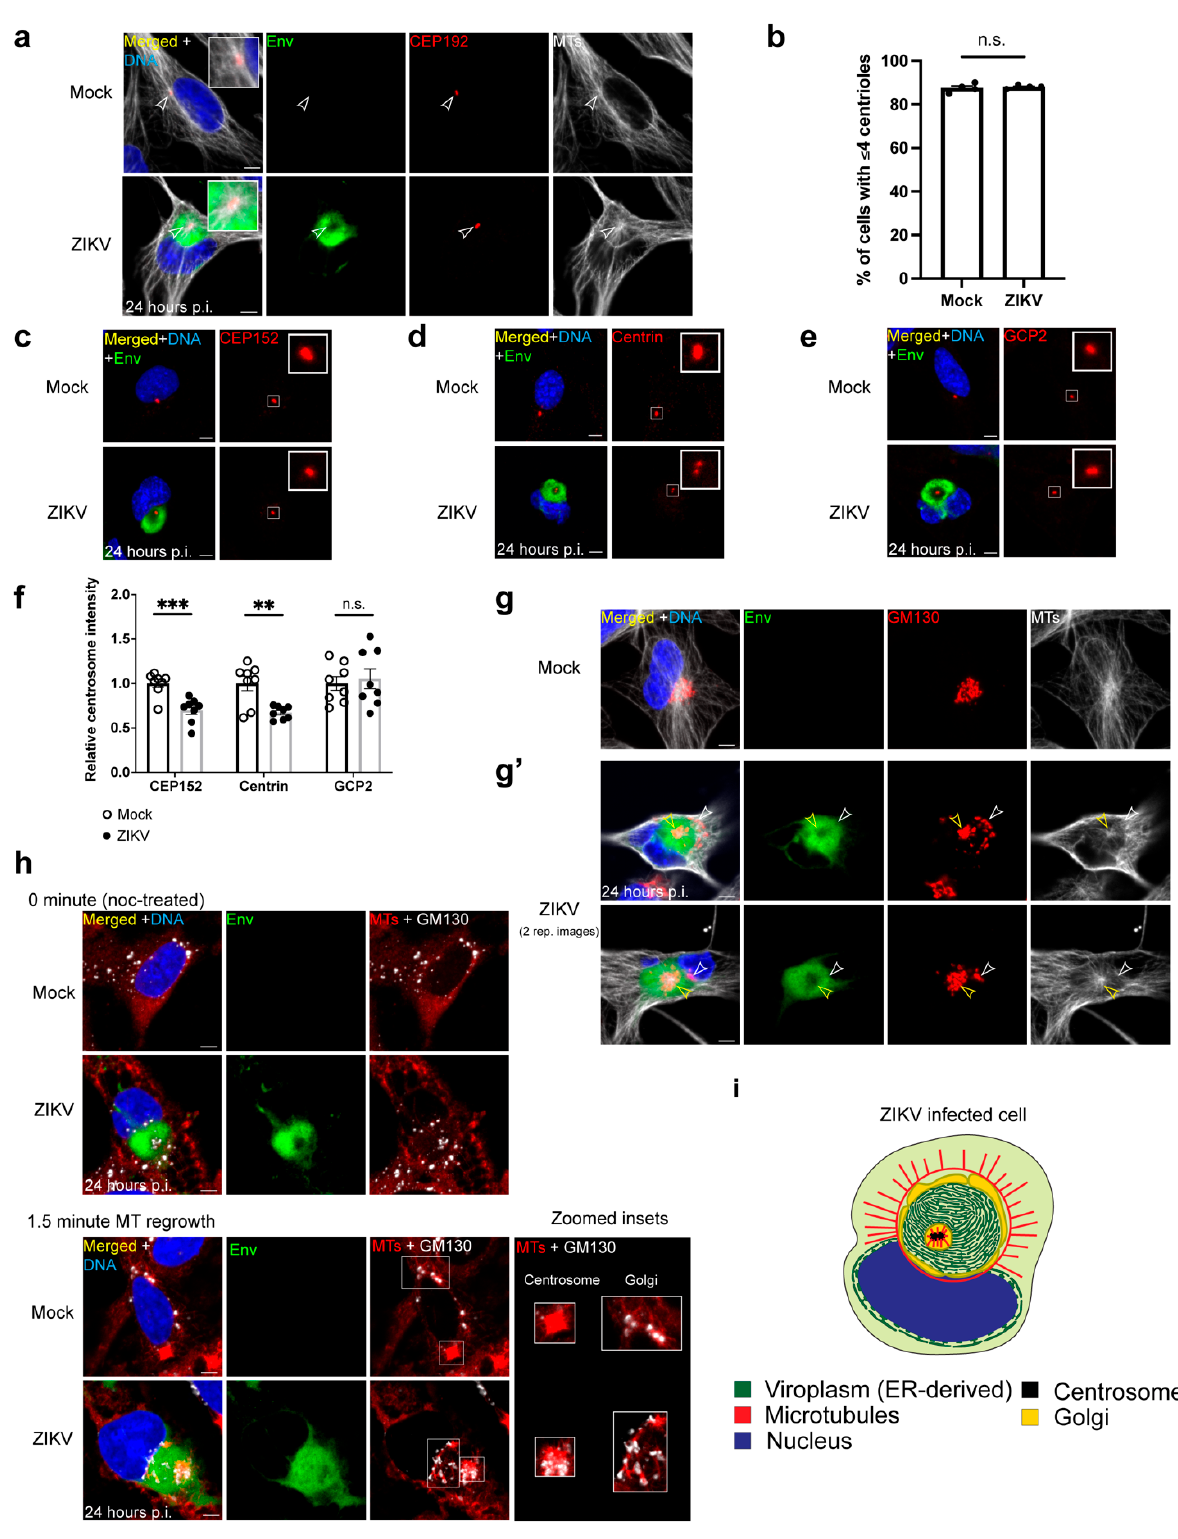
Figure 3. The centrosome and the Golgi MTOC associate with the ZIKV viroplasm, ( a ) IF staining for the centrosome protein CEP192 (red) in mock- and ZIKV (MR766)-infected SNB19 cells 24 h p.i. Viroplasms are marked by Env (green), and MTs are white. Insets show zoomed area where the centrosome is present, and arrowheads point to the centrosome; ( b ) quantification of the number of cells with 4 or fewer centrioles, measured by the number of centrin foci in mock- and ZIKV-infected cells 24 h p.i. T-test comparing centrosome number for the following conditions from four independent experiments (30–61 infected cells/experiment), mock vs. ZIKV ( p = 0.67, n.s.); ( c – e ) representative images of the centro- somal proteins (red) CEP152 ( c ), centrin ( d ), and gamma-tubulin complex protein 2 (GCP2) ( e ) staining in mock- and